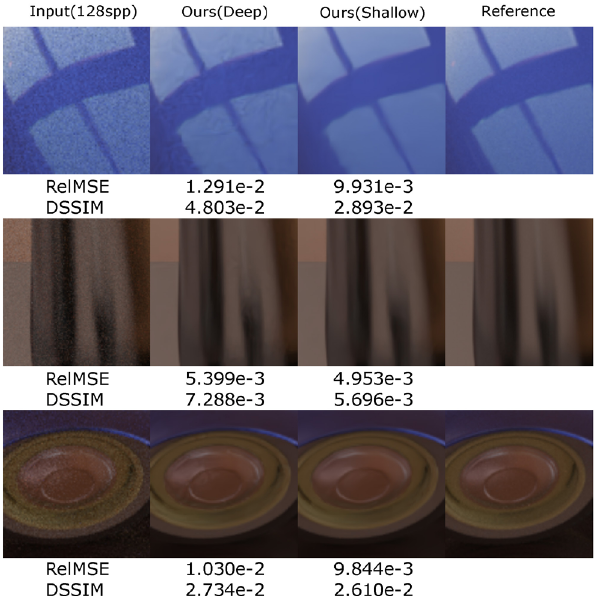
Fig. 12 Comparison of our method with shallow and deep kernel predictors.